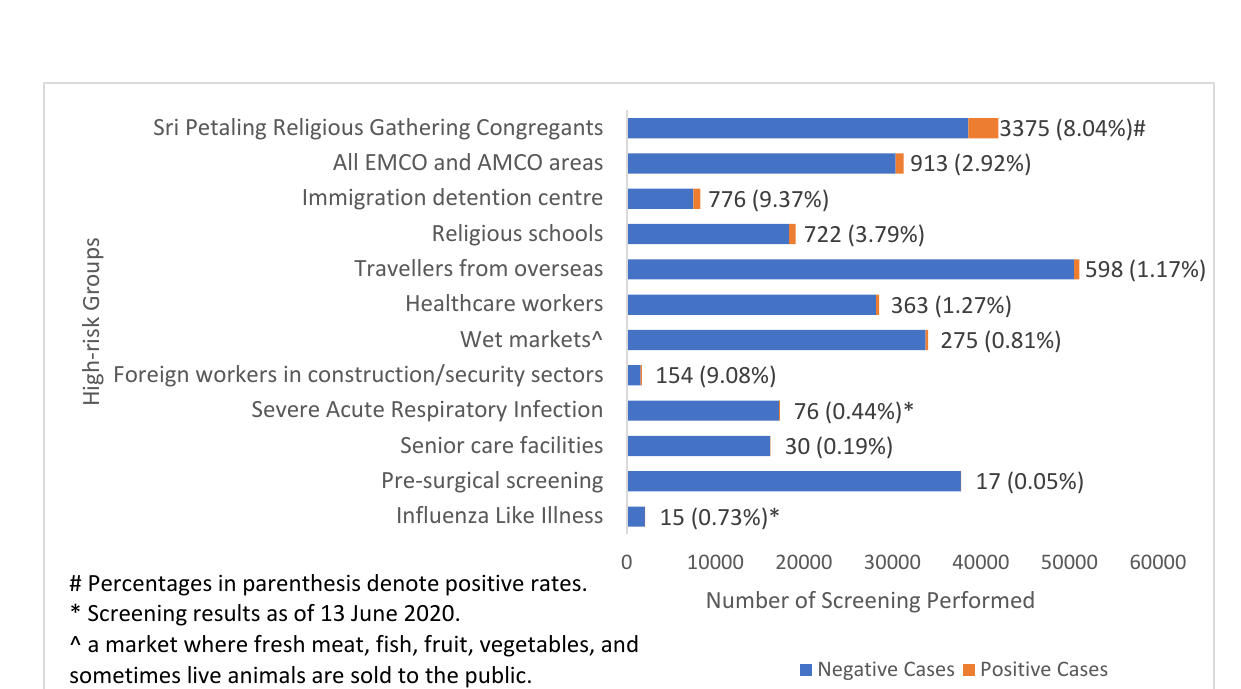
Figure 4. Targeted screening results for 12 identified high-risk groups as of 19 June 2020.